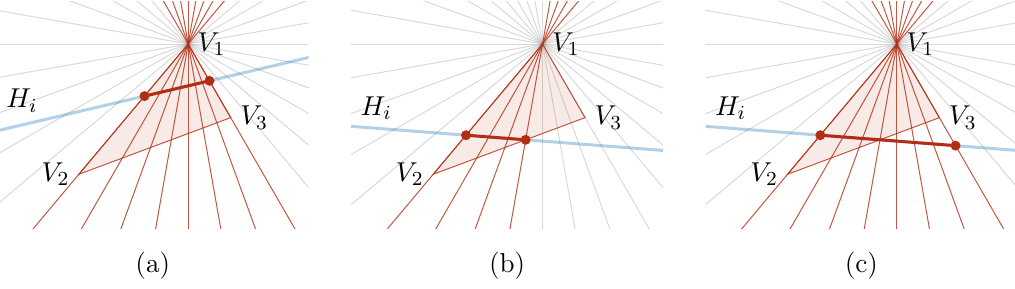
Figure 6 . The contour for the remaining variables in an actual discontinuity depends on the specific geometries of the original contour and of the original singularity hyperplane. Two examples are in (a) and (b). In (a) the remaining variables are integrated in the same way as the original contour, while in (b) the remaining contour changes. However, in our definition for the discontinuities in this paper, the remaining variables (that parameterize the space of fibres) are always integrated along the same contour as that in the original simplex. Therefore, (b) should be replaced by (c) in our analysis, while (a) is directly